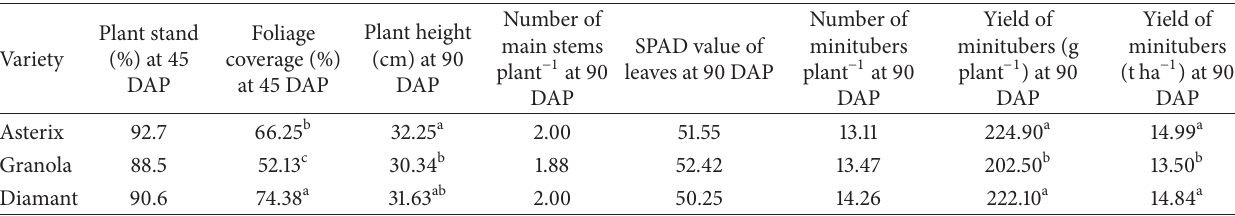
Table 1: Varietal performance of potato in field condition.